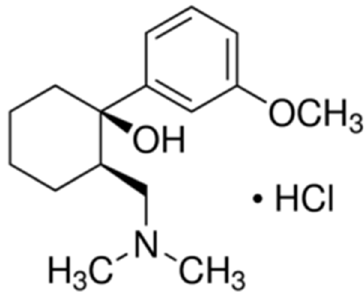
Figure 1. Chemical structure of tramadol hydrochloride. Tramadol’s extended-release pills and capsules are only prescribed for those who are likely to require pain relief 24 h a day; it belongs to the opiate (narcotic) analgesics class of drugs